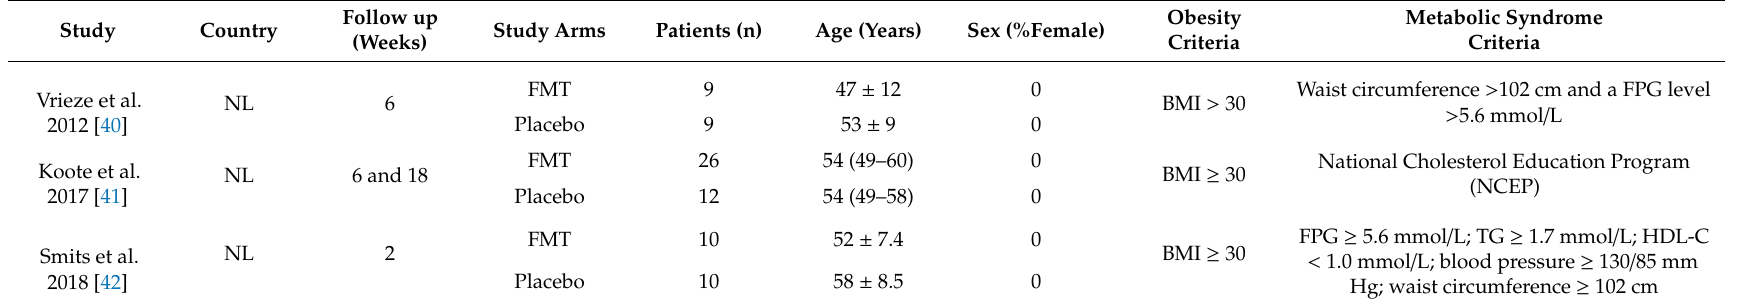
Table 1. Baseline demographics of included studies.